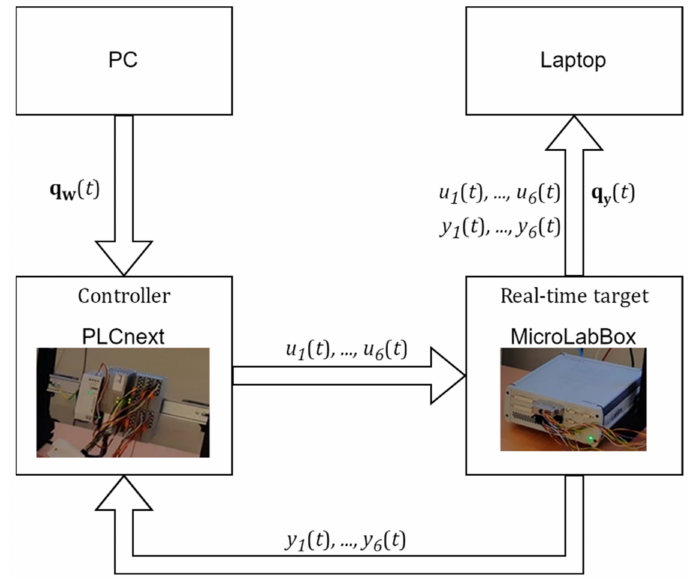
Figure 12. Stewart platform HiL simulation